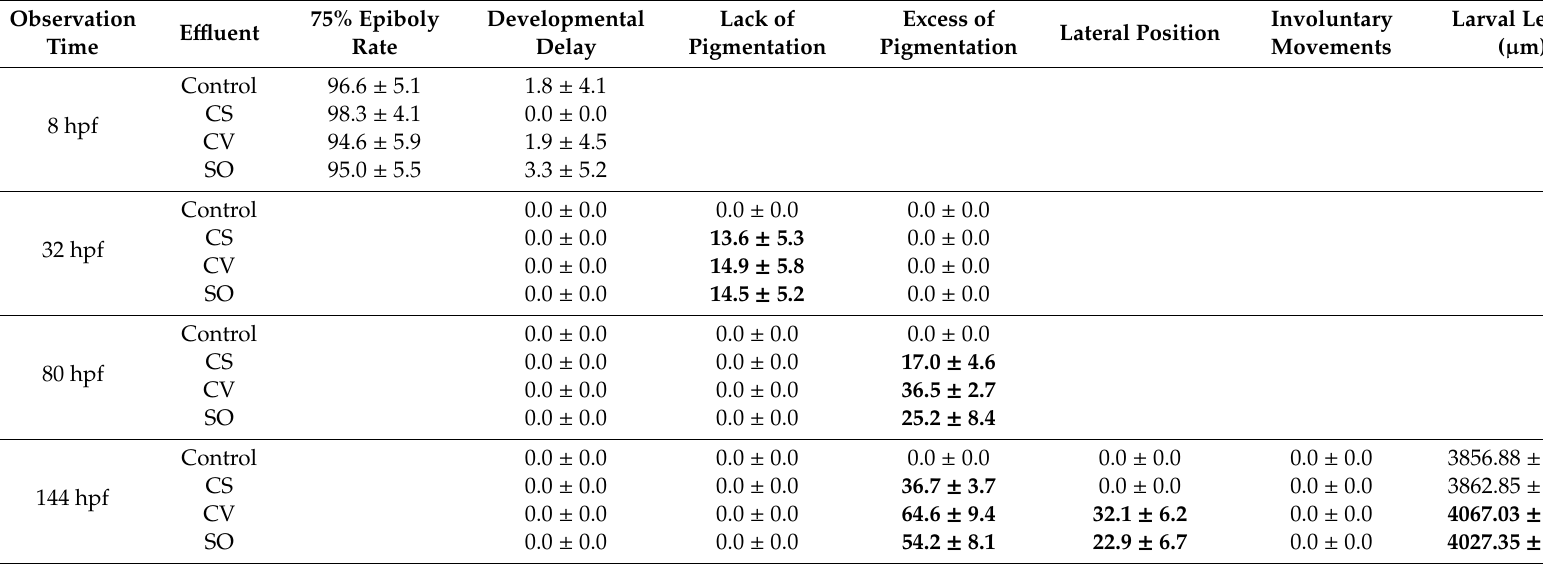
Table 2. E ff ects of exposure to microalgae treated e ffl uents on zebrafish embryos exposed to treated e ffl uents by CS, CV and SO embryos at the observation time-points considered in this work. Observation 75% Epiboly Developmental Lack of Excess of E ffl uent Lateral Position Rate Delay Pigmentation Pigmentation